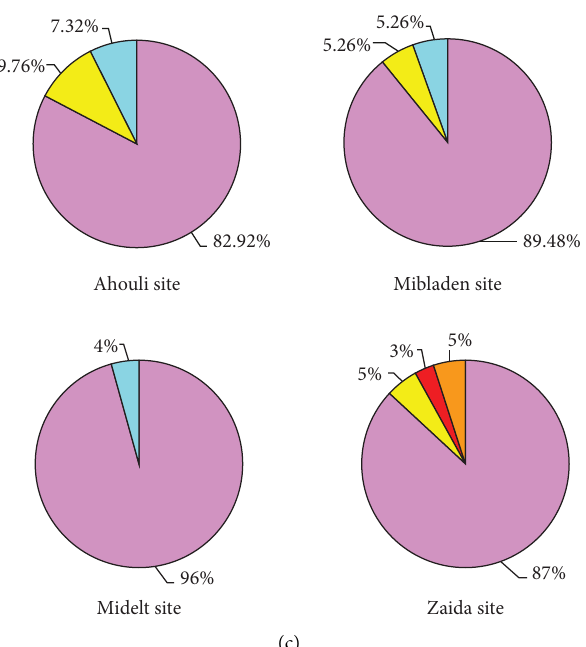
Figure 4: Diversity of culturable Actinobacteria isolated from lead mine sites. (a) Dendrogram showing the clustering of 145 actinobacterial isolates based on their biochemical characteristics. AI: Actinobacteria isolate. (b) Pie chart representation of the percentage frequency of actinobacterial genera in all sites and (c) within the total number of isolates in each